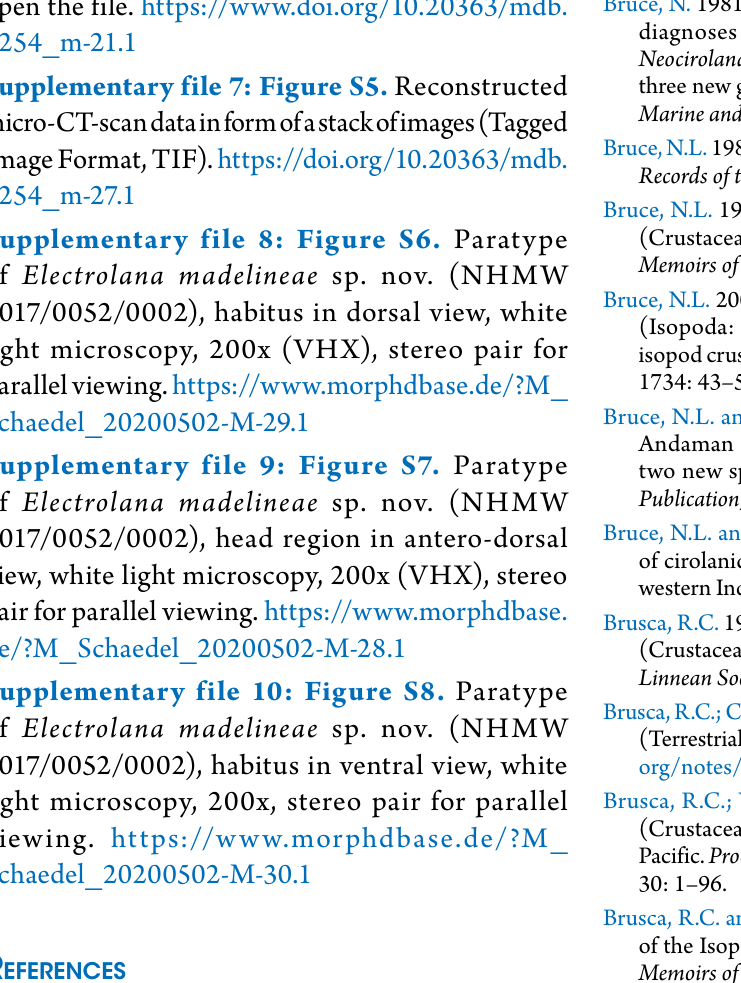
Supplementary file 7: Figure S5. Reconstructed micro-CT-scan data in form of a stack of images (Tagged